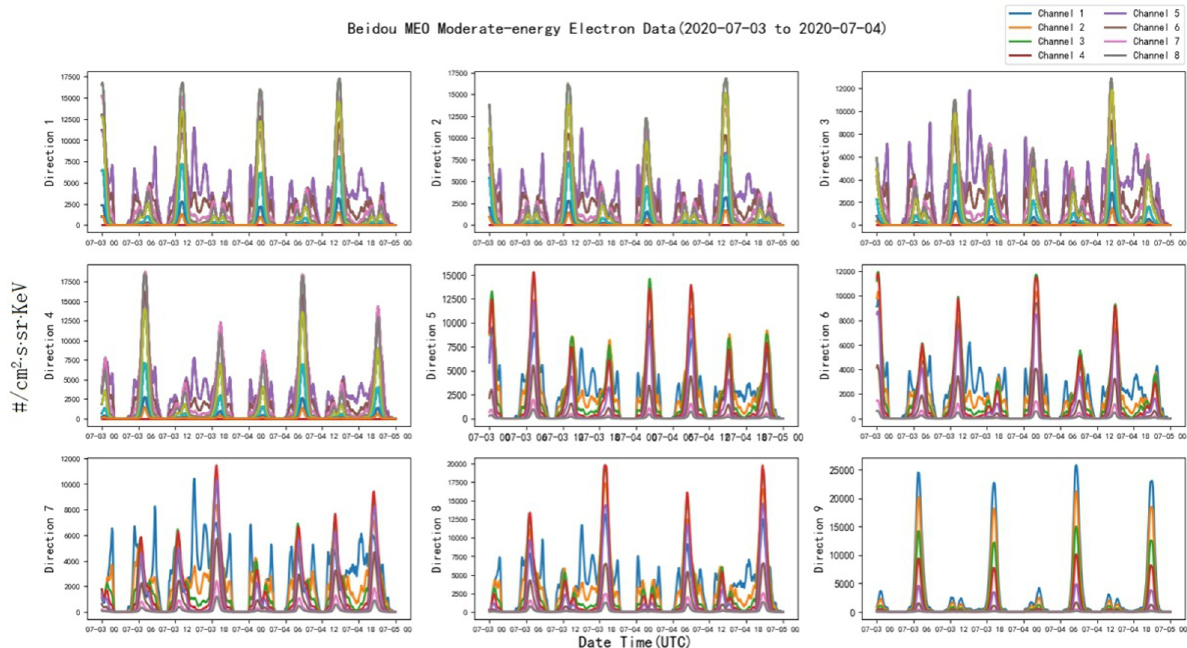
Figure 2: BeiDou moderate - energy electron data from July 3 to July 4, 2020.